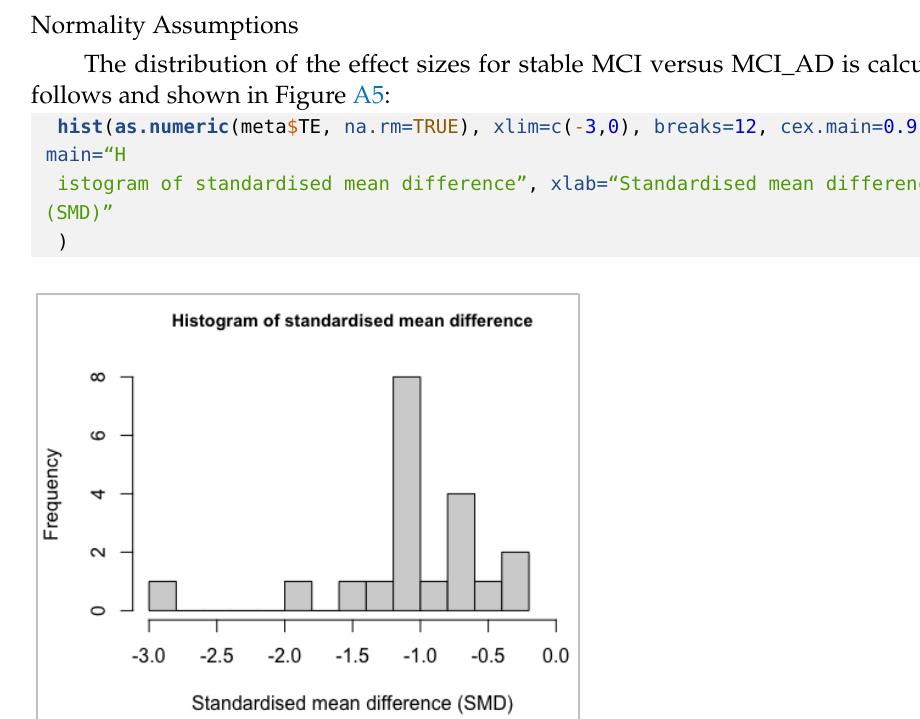
Figure A5. The distribution of the SMD of stable MCI versus MCI_AD is slightly skewed and shows an outlier, but is still within an acceptable range of a normal distribution.